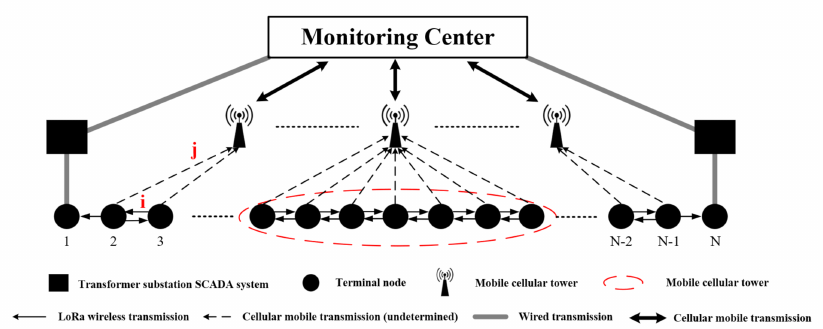
Figure 4. Network data transmission